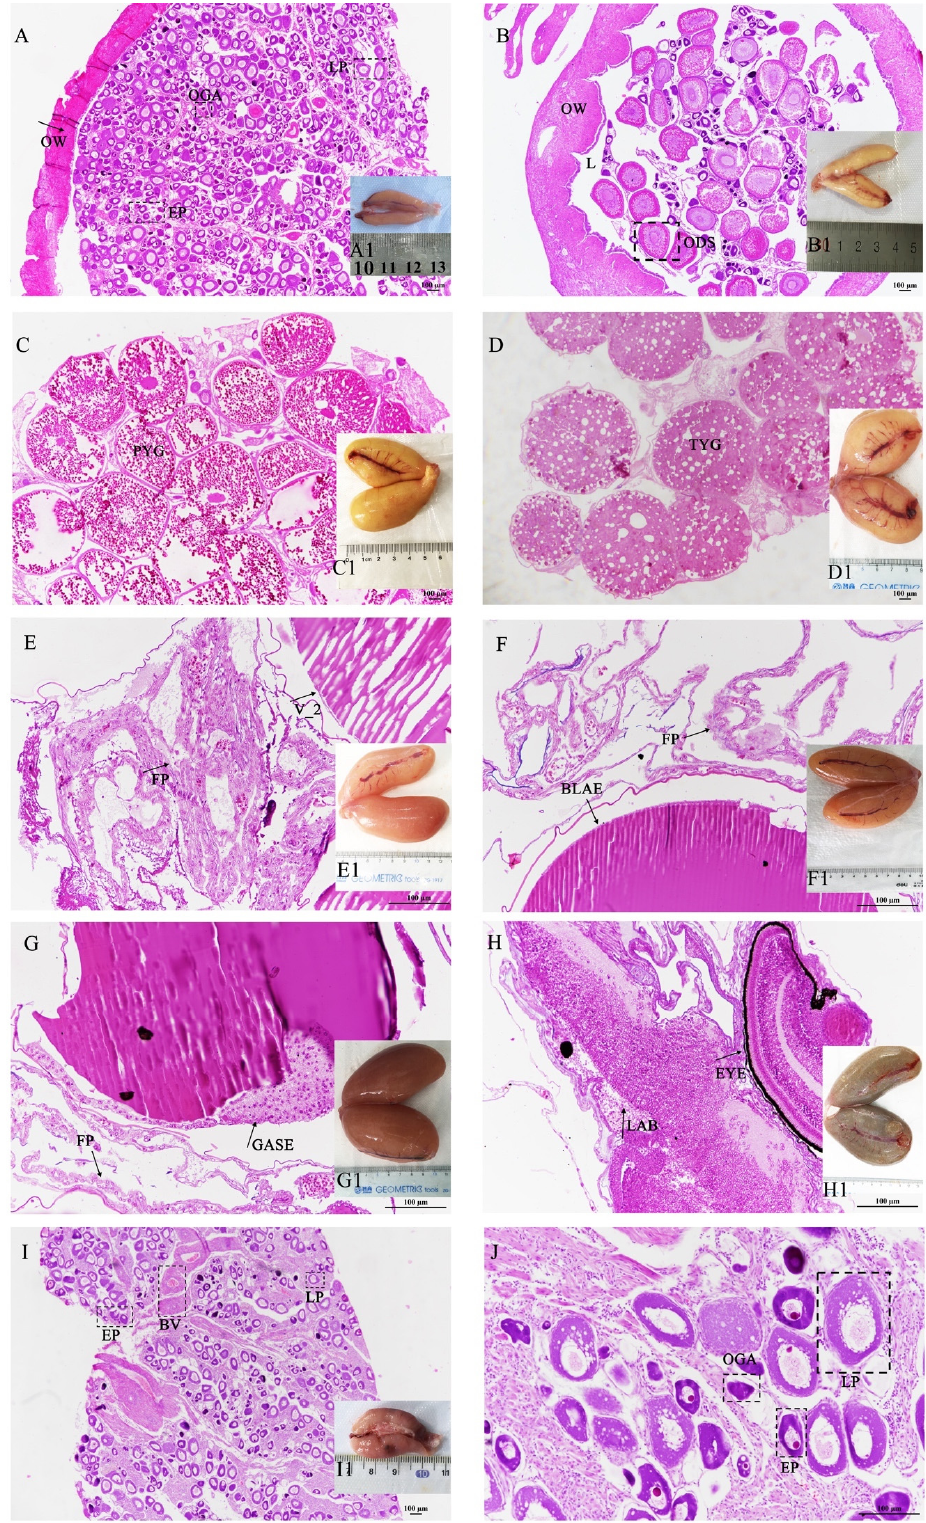
Figure 2. The characteristics of the ovary during the different developmental stages. ( A ) II stage, ( B ) III stage, ( C ) IIIIV stage, ( D ) V_1 stage, (E) V_2 stage, ( F ) bla stage, ( G ) gas stage, ( H ) lab stage, ( I ) VI stage, ( J ) high resolution of I image (scalebar, 100 µ m). At the MII stage, the ovary shape was cylindrical, and its color was pink ( A1 ). The cell type was mainly the oogonium and early peri-nucleolus ( A ). At the MIII stage, the ovary volume expanded, and the color was light